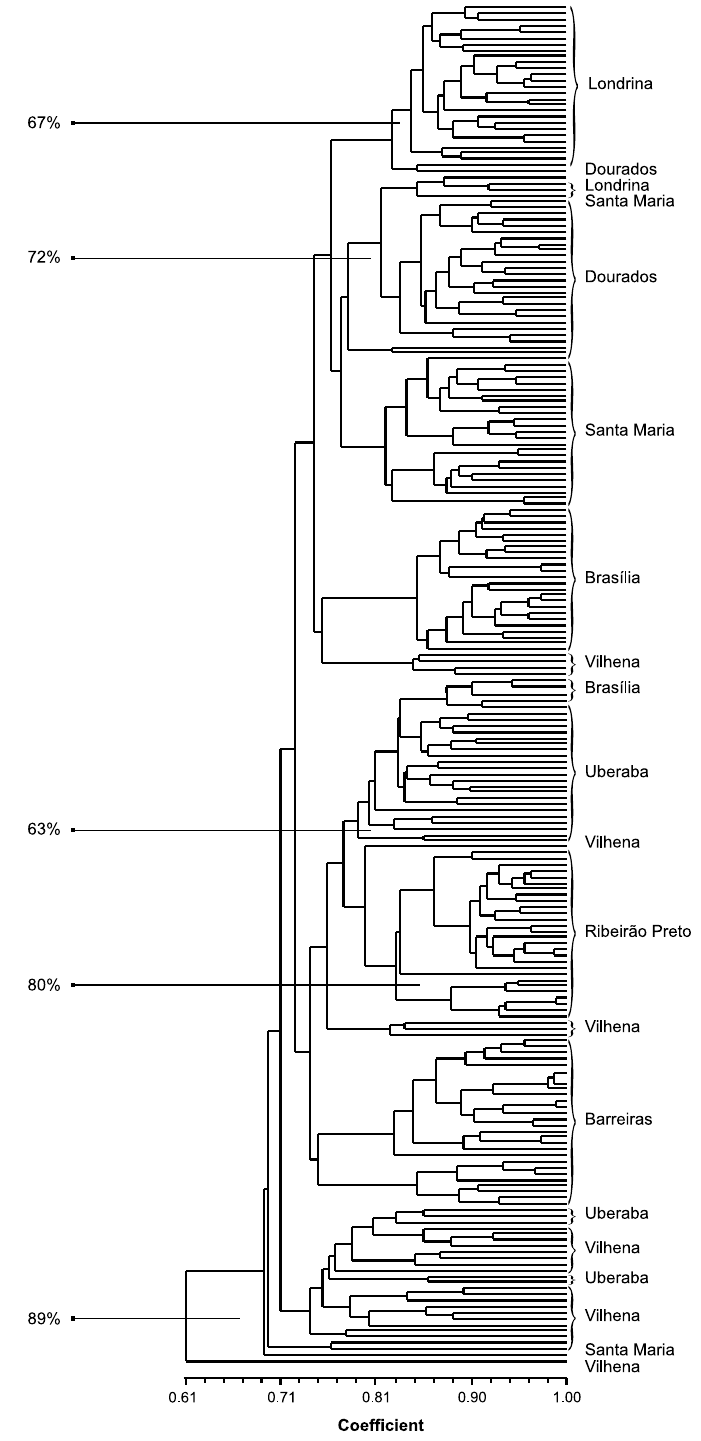
Fig. 2 – Dendogram of 224 individuals of Chlosyne lacinia saundersii collected in eight Brazilian states. The Dice coefficient was calculated usingtheallelfrequencyoftheRAPDmarkers, beingthedendogramgeneratedbyunweightedpair-groupmethodwitharithmeticmean(UPGMA). The values in % indicate the number of times the insects were grouped together in 1.000 cycles of the bootstrap analysis, using the computer program Applied Maths